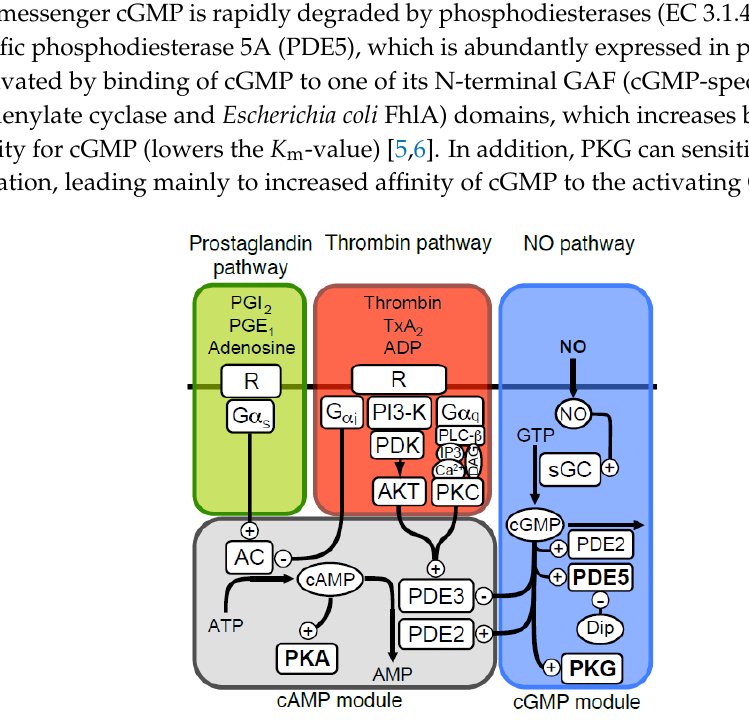
Figure 1. Signalling pathways affecting platelet cyclic nucleotides. An overview of the platelet signalling pathways which influence cGMP and cAMP levels are shown; nitric oxide (NO) stimulate cGMP production by activating soluble guanylate cyclase (GC). The cGMP signal is degraded by phosphodiesterases (PDEs), where PDE5 dominates and PDE2 contributes slightly. The cGMP dependent protein kinase is activated by cGMP and executes much of the signalling by phosphorylating important target proteins. The cGMP module also mediates cross-talk with the cAMP-module through cGMP production that stimulates (PDE2) or inhibits (PDE3) cAMP phosphodiesterases. cAMP is produced by adenylate cyclase (AC, EC 4.6.1.1) that is activated by Gα s stimulation, elicited by receptor binding of ligands such as prostaglandins (PGI 2 , PGE 1 ) or adenosine. Platelet agonists such as thrombin, ADP and thomboxane (TxA 2 ) will inhibit cAMP signalling, by inhibiting AC through inhibitory Gα i , or by increased cAMP degradation through phosphorylation-mediated activation of PDE3 by AKT/PKB or PKC.